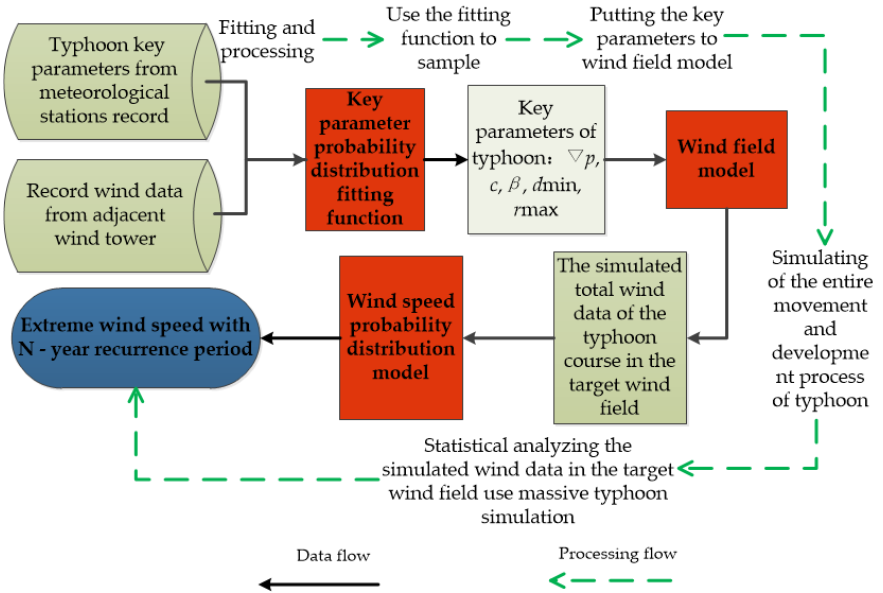
Figure 1. Flow chart of extreme wind speed (EWS) forecasts for offshore wind farms (OWF) by Monte Carlo method.